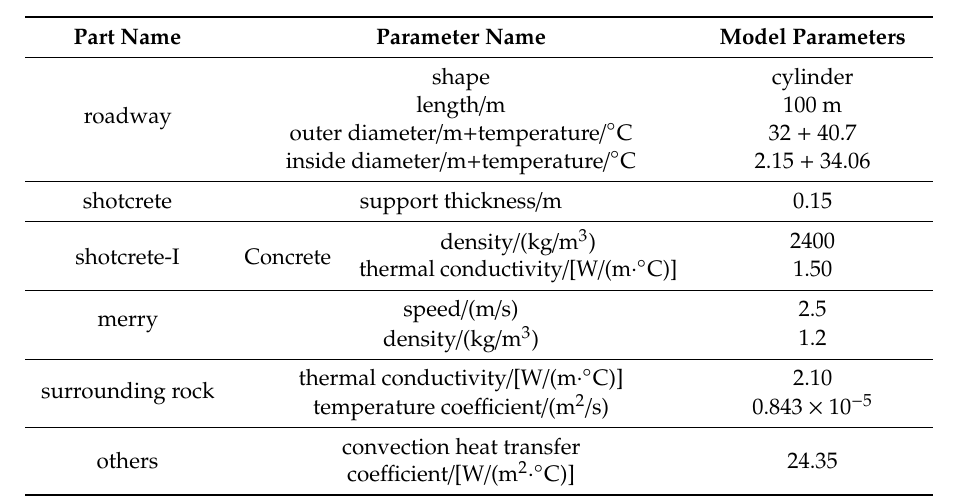
Table 8. Initial parameter settings